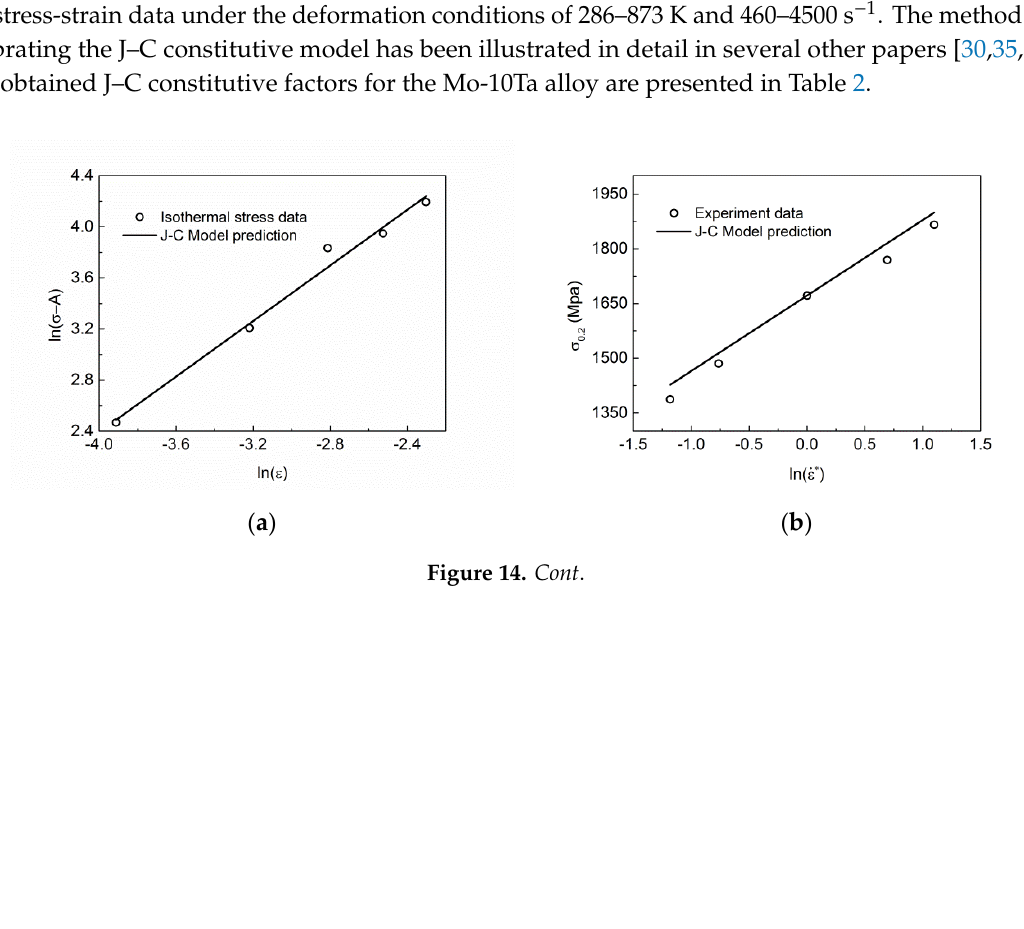
Figure 13. Microstructure of Mo-10Ta after plastic deformation (286 K, 4500 s −1 ), ( a ) 500×, ( b ) 1000×.